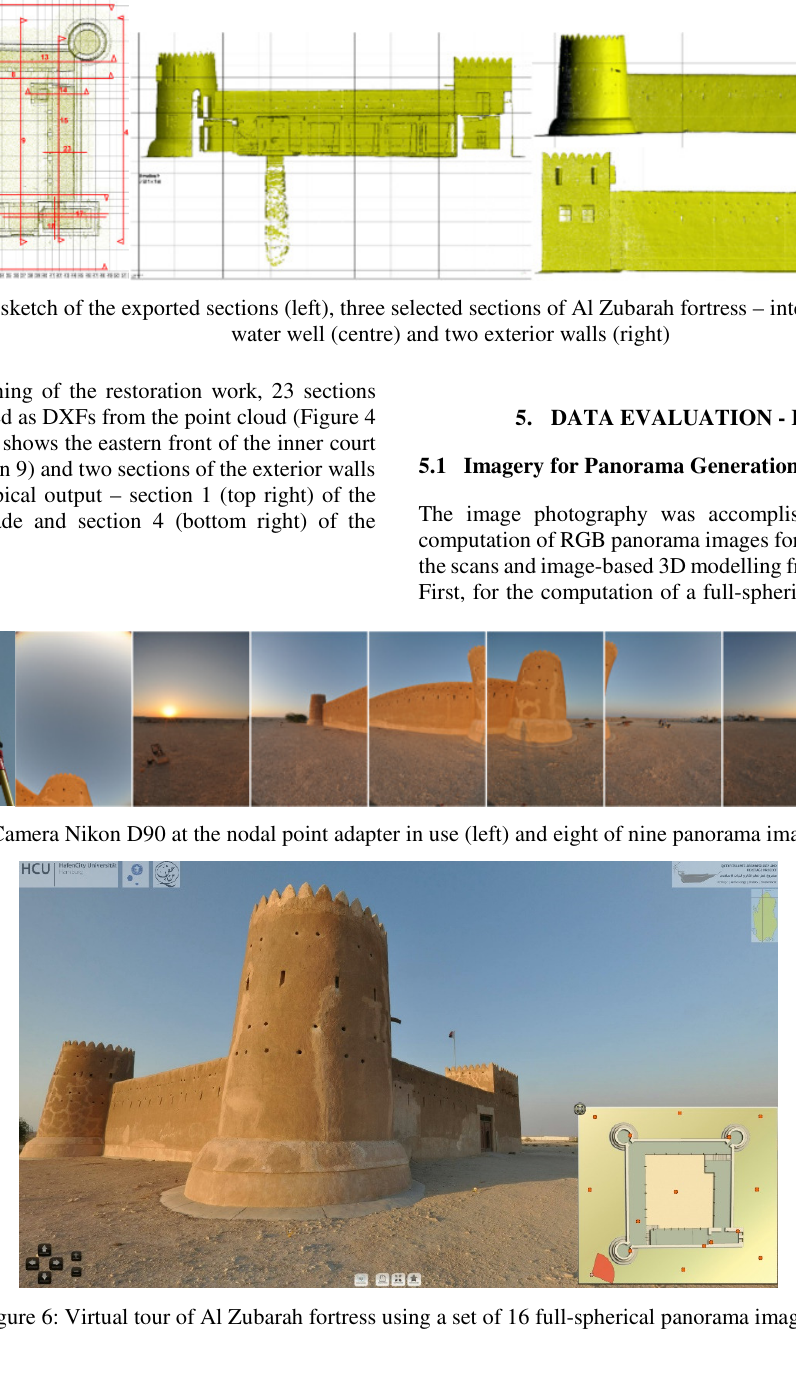
Figure 3: Al Zubarah fortress in Qatar as 3D point cloud (left) and as meshed 3D model (right)